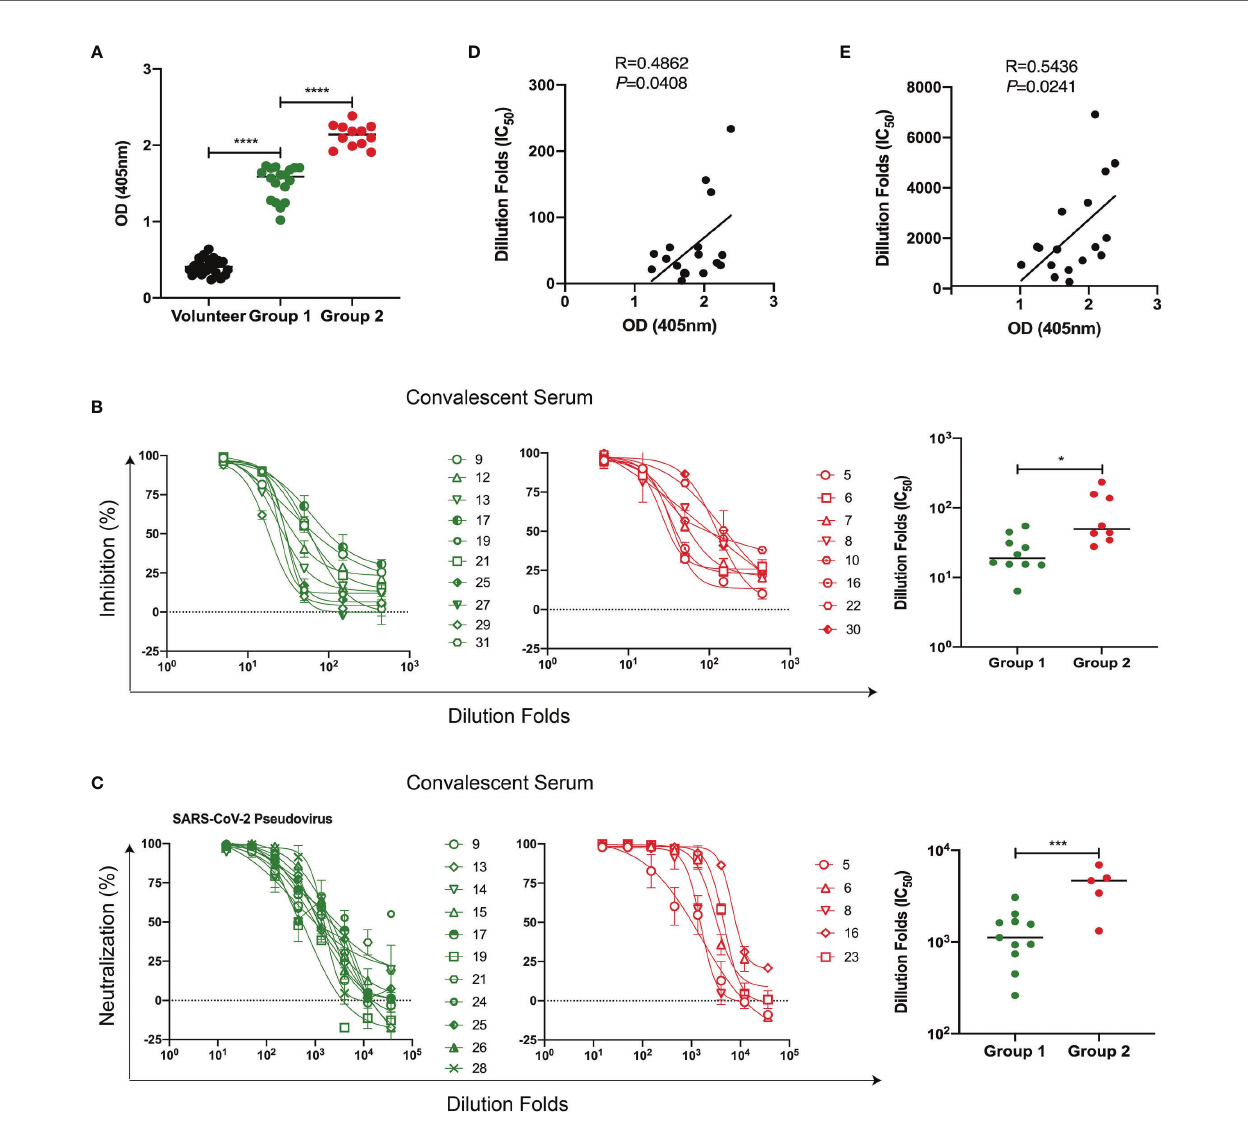
FIGURE 1 | Convalescent sera with high binding ability to RBD9.1 exhibited marked neutralizing capability against severe acute respiratory syndrome coronavirus 2 (SARS-CoV-2) pseudovirus. (A) Human convalescent serum collected from recovered SARS-CoV-2 subjects (N = 31) and serum from healthy volunteers (N = 20) were analyzed for RBD9.1 binding capability. Different groups represented convalescent serum samples with a low (Group 1) or a high (Group 2) amount of RBD9.1- speci fi c antibodies. (B) Receptor-binding domain (RBD) – hACE2 interaction inhibition titers (N = 18) and (C) SARS-CoV-2 pseudovirus neutralization titers (N = 16) were analyzed based on patients from Group 1 and Group 2. Each curve or points represented individual patients. Green: Group 1; red: Group 2. RBD9.1 binding antibodies were analyzed for the correlation with (D) RBD – hACE2 interaction inhibition titers (IC 50 ) and (E) SARS-CoV-2 pseudovirus neutralization titers (IC 50 ). Points or curve represent individual patients; horizontal lines indicate mean titers (MTs) of IC 50 for each group ± SEM. * P < 0.05, *** P < 0.001, **** P <